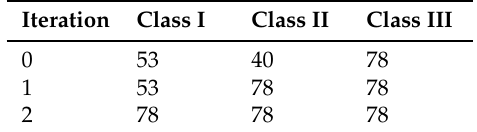
Table 5. Ecuador—Random Over-sampling of data [61].